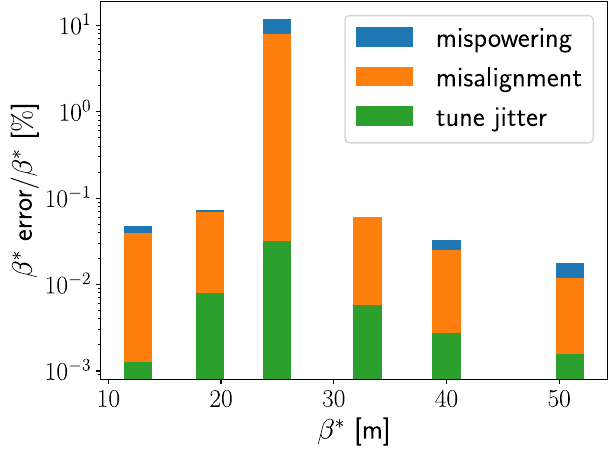
FIG. 5. Contribution of different errors to the total error in the β (cid:1) determination from K modulation for B1 vertical plane in IP1 for different optics configurations.